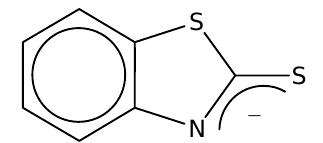
Figure 8 . Resonance structure of benzothiazole-2-thiolate